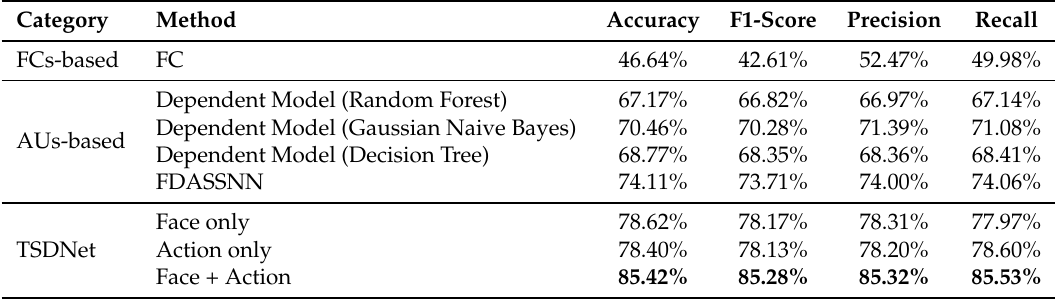
Table 2. Performance comparison among two-leveled stress detection network (TSDNet) and two other categories of video-based stress detection